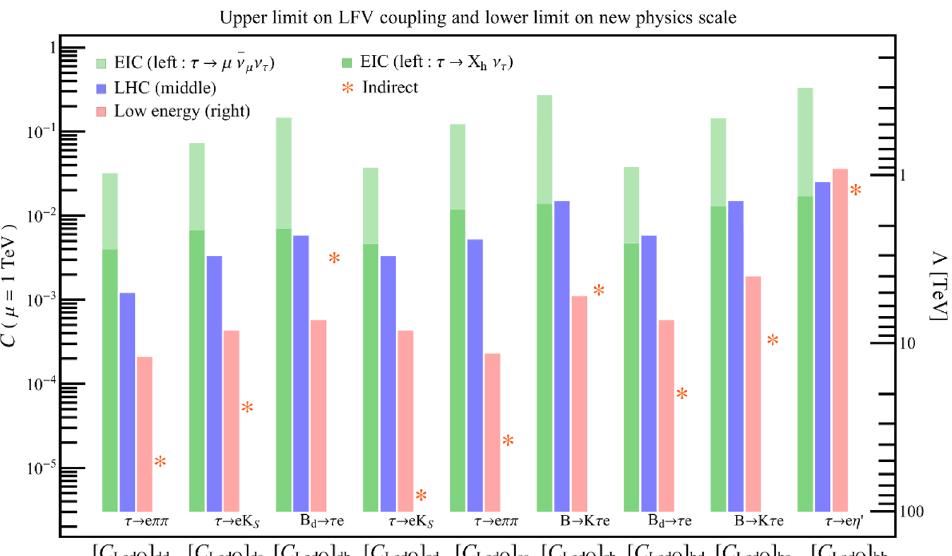
Figure 20 . Upper limit on C LedQ (leftmost axis) and lower limit on new physics scale Λ (rightmost axis). For the EIC expected sensitivity, the light green bar corresponds to the result in table 7, while the dark green one represents the case in hadronic tau decay mode assuming (cid:15) n b = 0 in tables